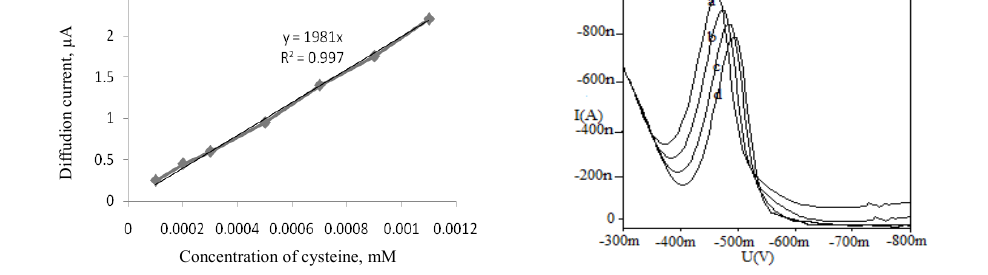
Figure 4. (a) Differential Pulse Polarogram of a fixed concentration of cysteine (2 mM).(b): (a) +0.1mM of crocin (c): (b)+ 0.1mM of crocin (d): (c)+0.1mM of crocin in 0.02M NaCl, pH 5.2±0.01, scan rate 20 mV/s, pulse amplitude 50